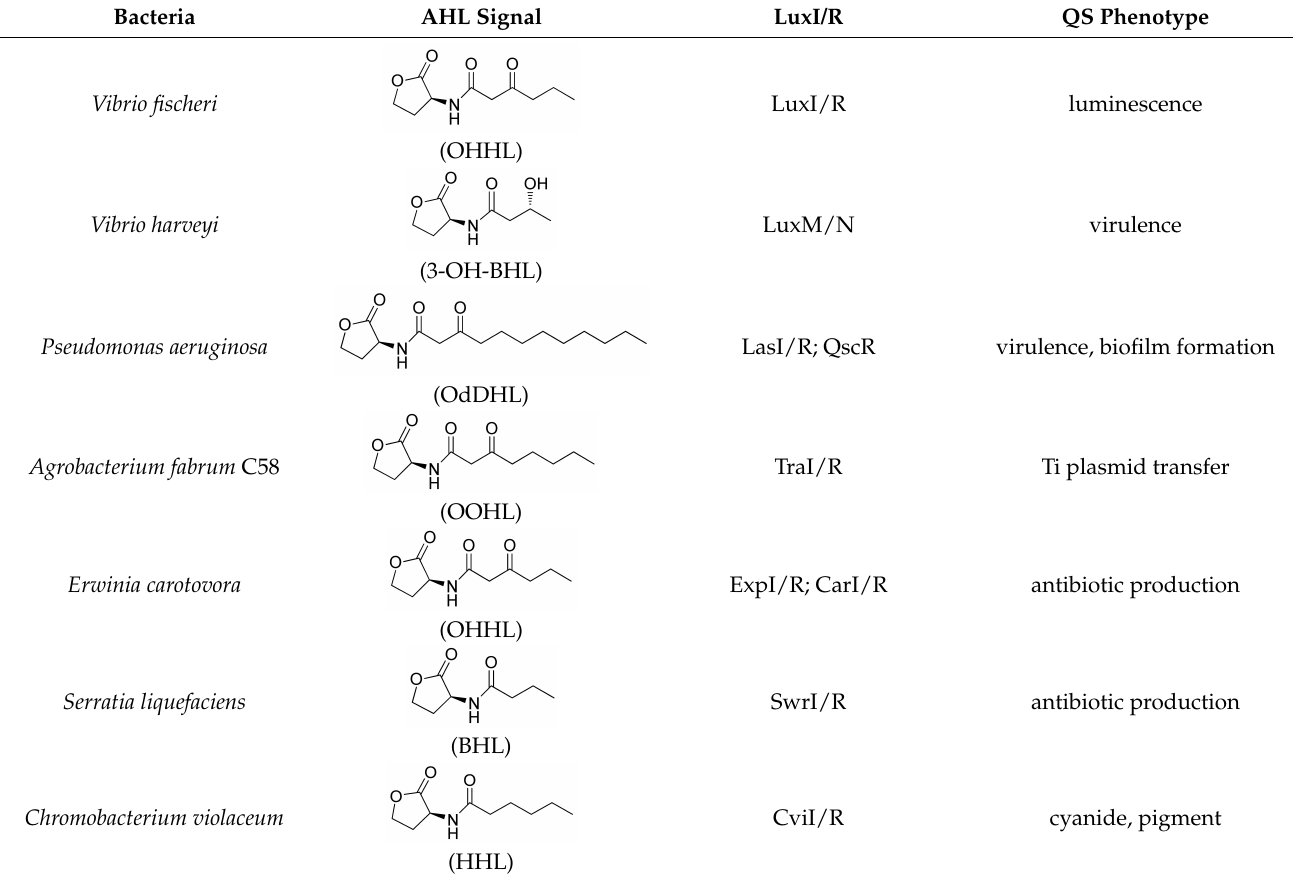
Table 1. Representative strains, phenotype, receptors, and structures in AHL-dependent